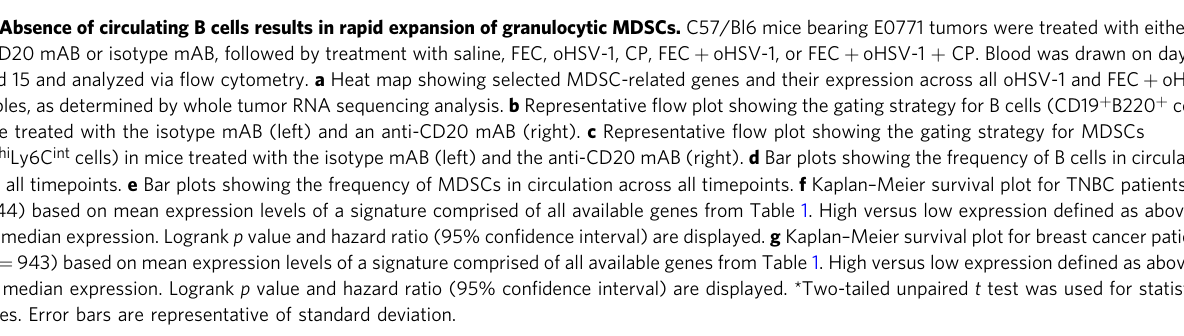
Fig. 7 Absence of circulating B cells results in rapid expansion of granulocytic MDSCs. C57/Bl6 mice bearing E0771 tumors were treated with either an anti-CD20 mAB or isotype mAB, followed by treatment with saline, FEC, oHSV-1, CP, FEC + oHSV-1, or FEC + oHSV-1 + CP. Blood was drawn on days 6, 10, and 15 and analyzed via fl ow cytometry. a Heat map showing selected MDSC-related genes and their expression across all oHSV-1 and FEC + oHSV- 1 samples, as determined by whole tumor RNA sequencing analysis. b Representative fl ow plot showing the gating strategy for B cells (CD19 + B220 + cells) in mice treated with the isotype mAB (left) and an anti-CD20 mAB (right). c Representative fl ow plot showing the gating strategy for MDSCs (Ly6G hi Ly6C int cells) in mice treated with the isotype mAB (left) and the anti-CD20 mAB (right). d Bar plots showing the frequency of B cells in circulation across all timepoints. e Bar plots showing the frequency of MDSCs in circulation across all timepoints. f Kaplan – Meier survival plot for TNBC patients OS ( n = 144) based on mean expression levels of a signature comprised of all available genes from Table 1. High versus low expression de fi ned as above or below median expression. Logrank p value and hazard ratio (95% con fi dence interval) are displayed. g Kaplan – Meier survival plot for breast cancer patients OS ( n = 943) based on mean expression levels of a signature comprised of all available genes from Table 1. High versus low expression de fi ned as above or below median expression. Logrank p value and hazard ratio (95% con fi dence interval) are displayed. *Two-tailed unpaired t test was used for statistical analyses. Error bars are representative of standard